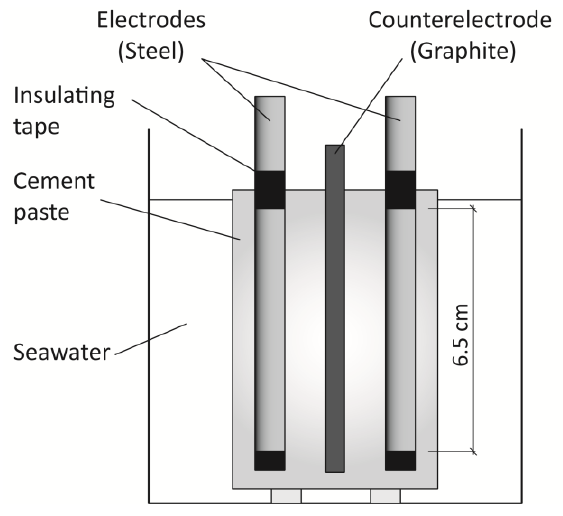
Figure 6. Specimen partially immersed in seawater for chloride attack